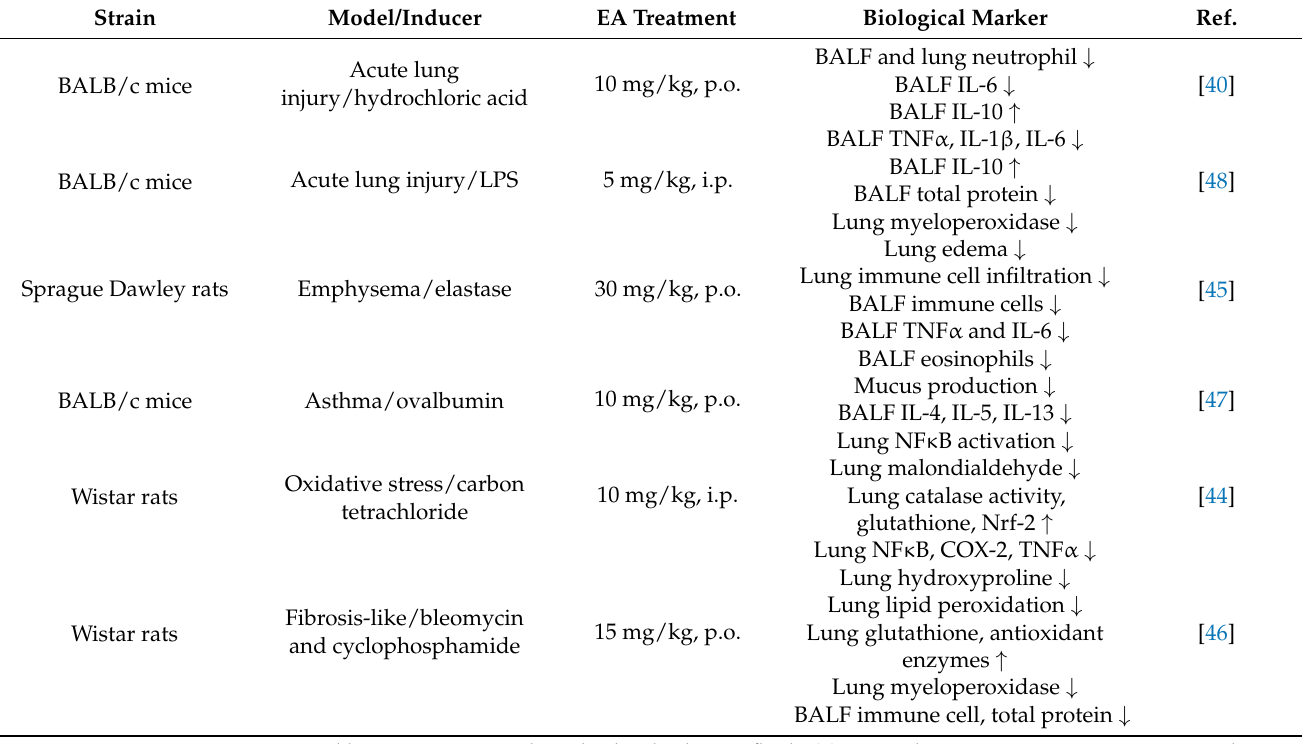
Table 2. Beneficial effects of ellagic acid (EA) in pulmonary pathology in experimental